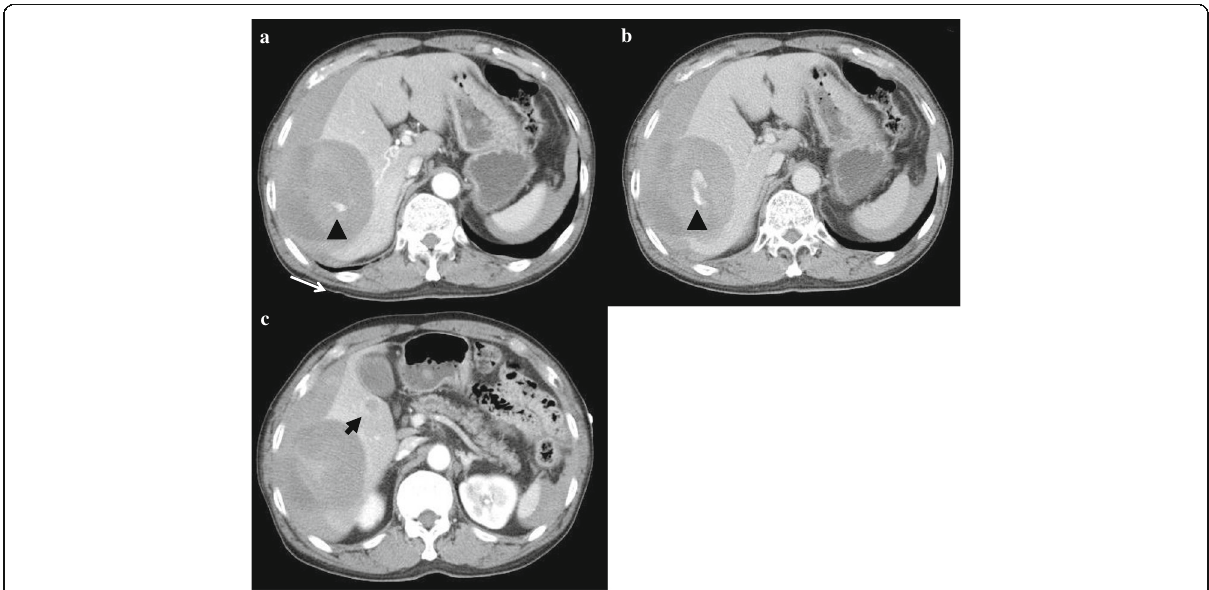
Fig. 1 Contrast-enhanced computed tomography scan showed a hypo-enhancing tumor (98 × 81 mm) in the posterior segment of the liver with intratumoral extravasation on arterial phase ( a ) and on delayed phase ( b ). A daughter tumor (12 × 10 mm) in segment 5 of the liver was also detected ( c